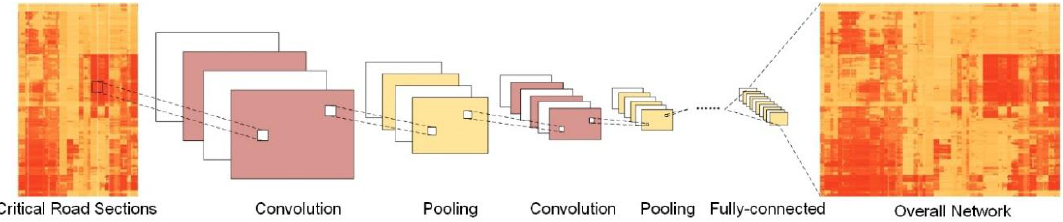
Figure 1. The process of shaping spatiotemporal matrix of critical road section: ( a ) A spatiotemporal matrix of overall network and ( b ) A spatiotemporal matrix of critical road sections.